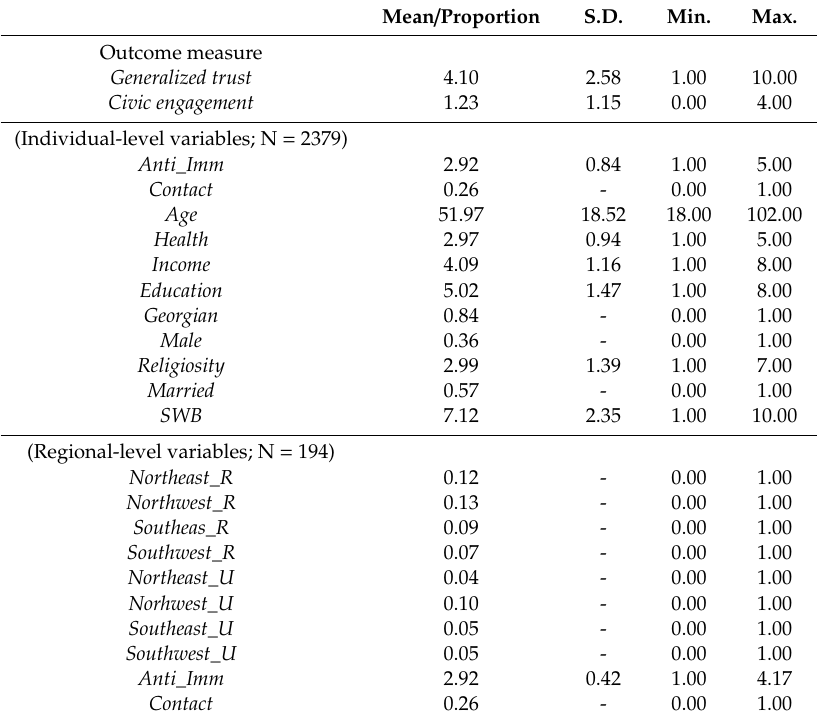
Table 1. Summary of Descriptive